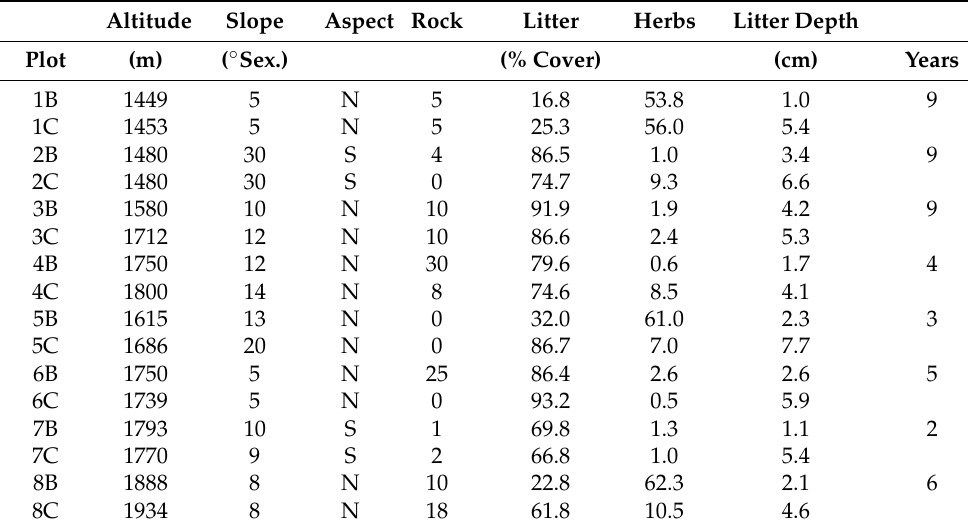
Table 1. Site description, cover type and years from the last prescribed burning. Altitude Slope Aspect